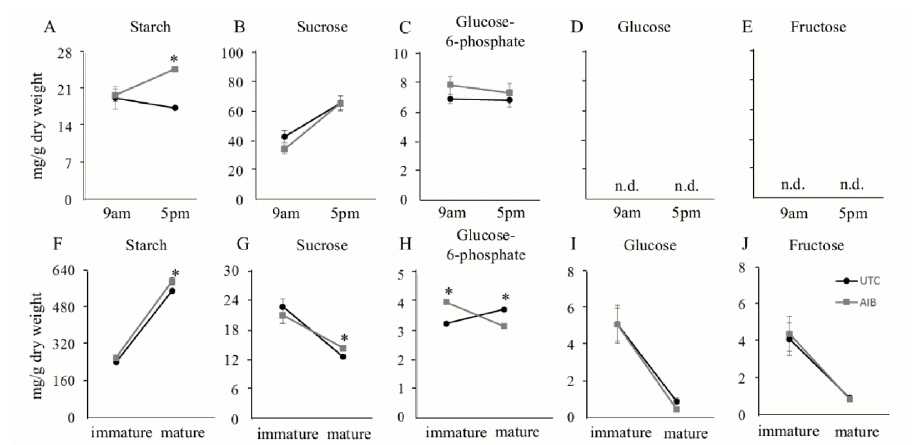
Fig 3. Starch and soluble sugars contents in source and sink tissues treated with Ethylene biosynthesis inhibitors. Starch (A,F), Sucrose (B,G), Glucose-6-phosphate (C,H), Glucose (D,I), Fructose (E,J) contents in flag leaves (A-E) and immature/mature grains (F-J) treated with UTC and AIB at post- anthesis stage. Values are Mean ± SE (n = 4). * indicates significance at P (cid:3) 0 . 05 ; n.d. indicates not